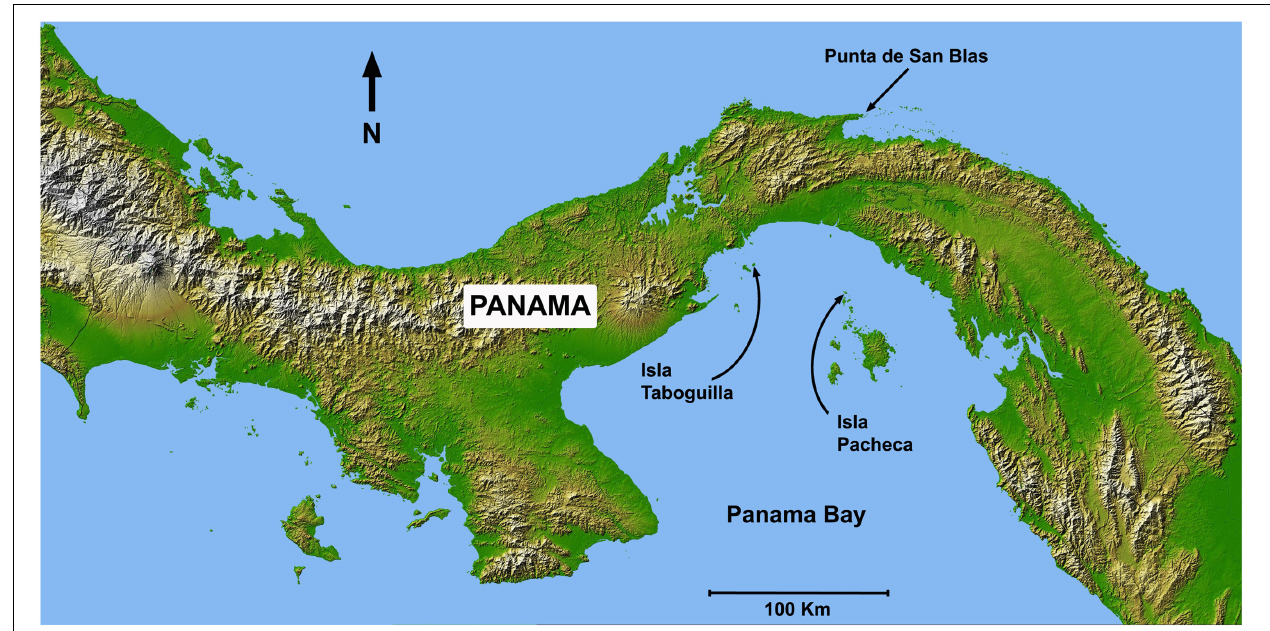
FIGURE 2 | Map of Panama showing Caribbean and Pacific study locations: Taboguilla Island (8.8 ◦ N, 79.51 ◦ W), Pacheca Island (8.65 ◦ N, 79.05 ◦ W), and Punta de San Blas (9.45 ◦ N, 78.99 ◦ W).